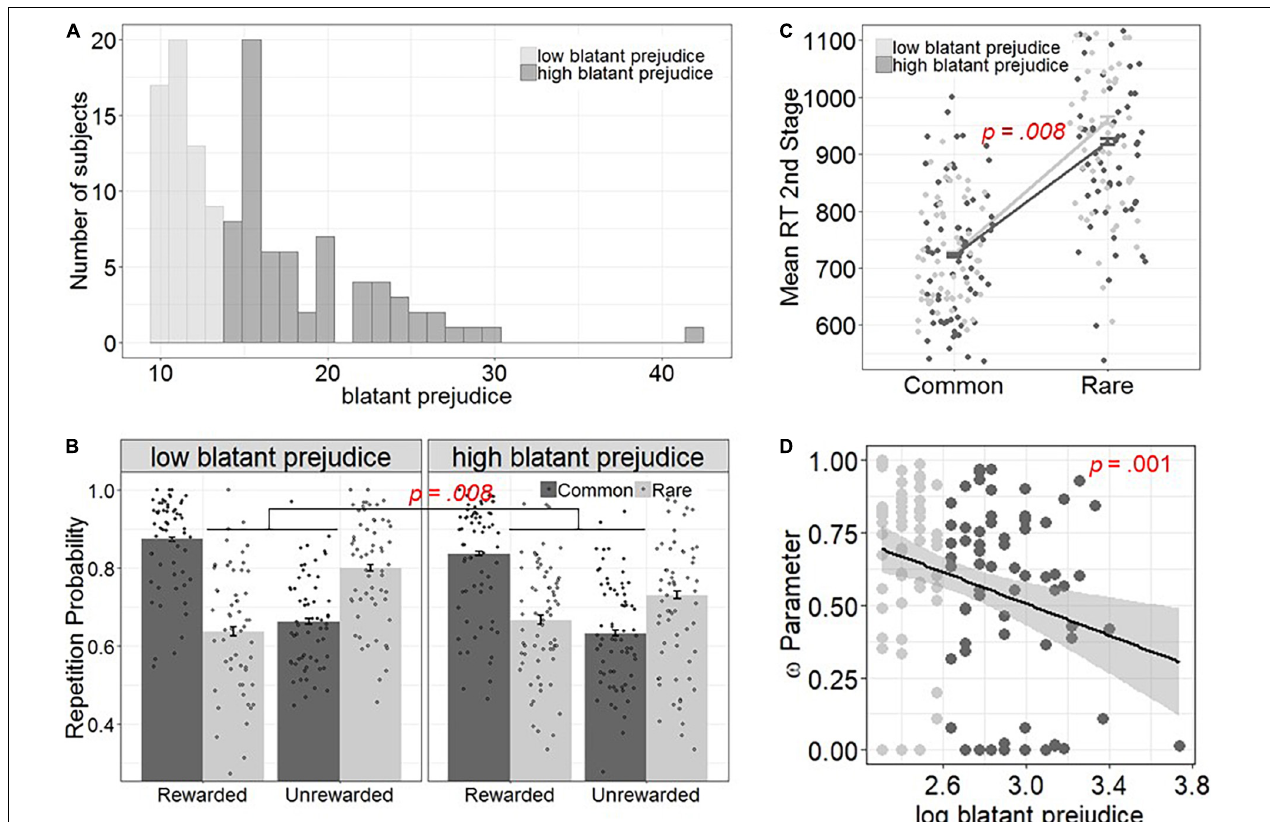
FIGURE 2 | Association between blatant prejudices and different measures of the balance between model-free and model-based control. For visualization we performed a median split of the blatant prejudice scale to disentangle subjects with low (questionnaire sum score < 14) and high ( > =14) prejudices. (A) Distribution of the blatant prejudice scale prior to log scaling and according to the median split. (B) Observed choice behavior for subjects with high and low prejudices. Subjects with high prejudices showed a significant decrease in model-based behavior. (C) Second stage RT analyses as a function of blatant prejudice and transition. Subjects with high prejudices made faster responses in rare compared to common trials, indicating reduced model-based control. The regression lines in (C,D) depict the linear smoothed conditional means. (D) The negative association between blatant prejudice and model-based control was also supported by the computational analyses, as higher ω parameters were associated with lower blatant